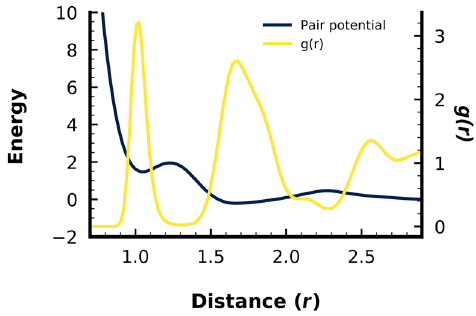
Fig. 8 Tabulated pair potential and radial distribution function for quasicrystal simulations. The single-component, isotropic pair potential (dark blue) used for all decagonal quasicrystal (d-QC) simulations is derived from the potential mean of force of a diamond-forming system 51 . The radial distribution function is shown in yellow, g ( r ), for a single-seeded d-QC simulation after 19.7×10 6